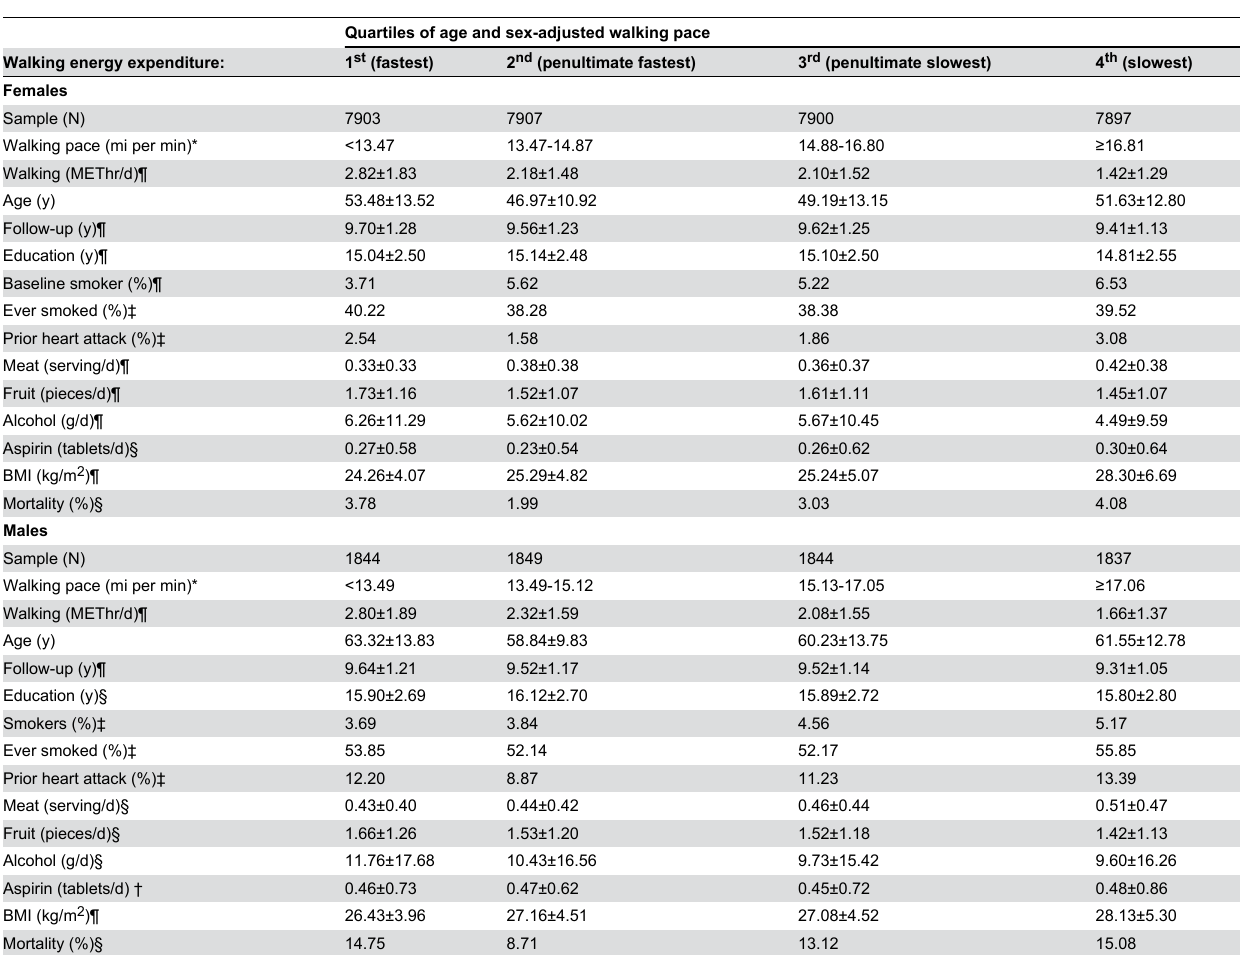
Table 1. Sample characteristics (percent or mean±SD) by walking pace.